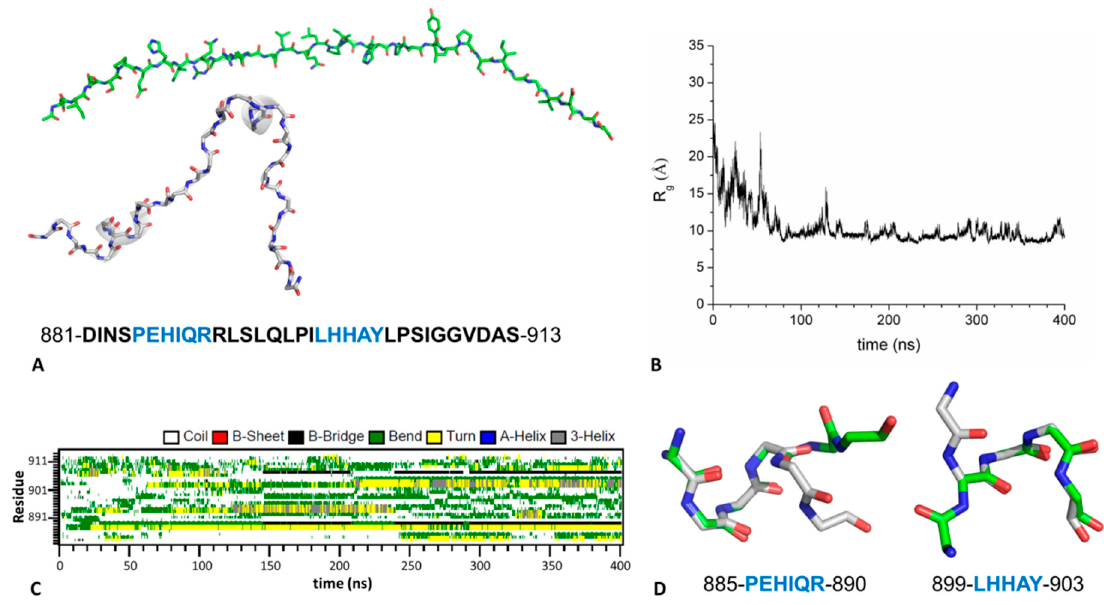
Figure 8. Representation of the fully extended structure ( ϕ = − 120 ◦ , ψ = 130 ◦ , ω = 180 ◦ ) (green) of the GABA B2 R peptide (residues 881-913) used as starting model in the MD simulation of the isolated peptide. The aminoacid sequence and the structure (grey) of the peptide extracted from the crystallographic complex with KCTD16 BTB (PDB ID: 6M8R) are also shown. Residues 885-890 and 899-903 which adopt a helical conformation are colored in blue in the sequence ( A ). Time evolution of the radius of gyration R g ( B ) and of the secondary structure content ( C ) of GABA B2 R peptide. Representative examples of the conformational states detected in the simulation (green) superimposed to the crystallographic model (grey) in the regions 885-890 and 899-903 ( D ).